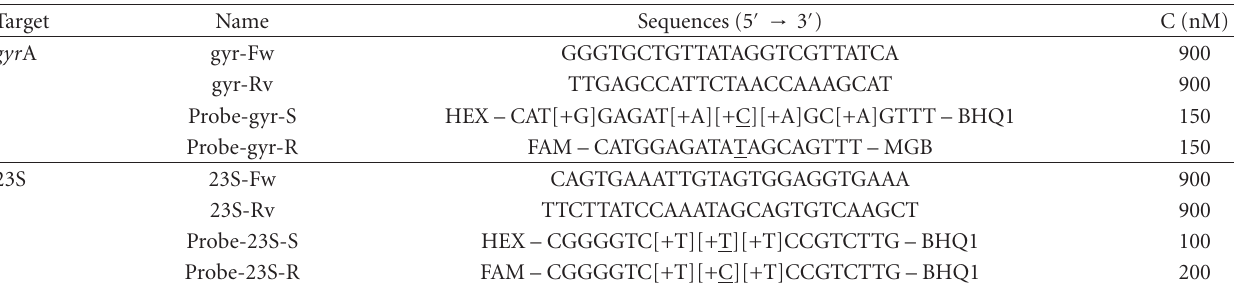
Table 2: Primers and probes